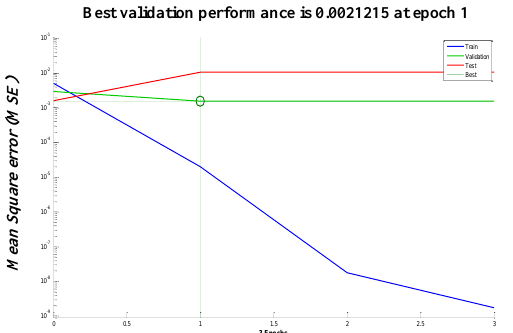
Figure 20. The performance of the proposed MLP neural network training